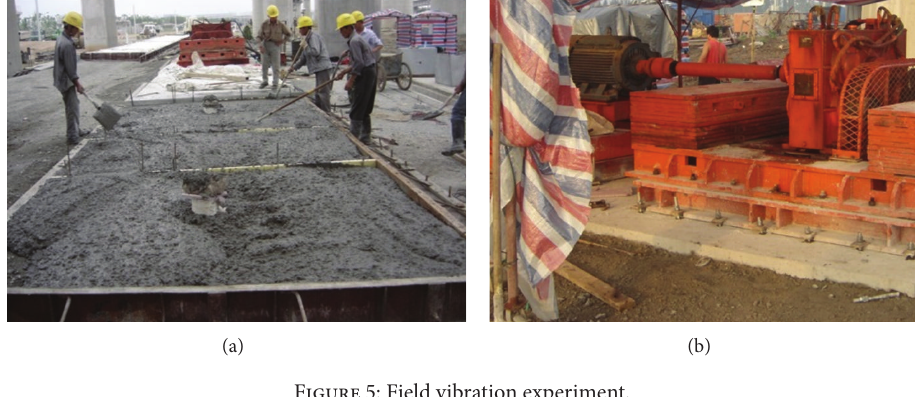
Figure 5: Field vibration experiment.